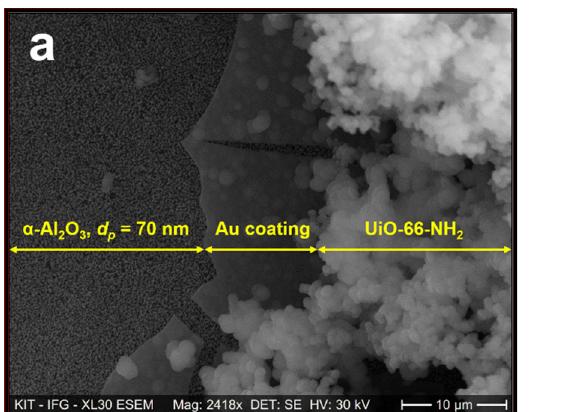
Figure 3. Normalized diffractograms of the four UiO-66-NH 2 membranes. The plots of U-LBL and U-LBL-d have been recently published elsewhere [35].